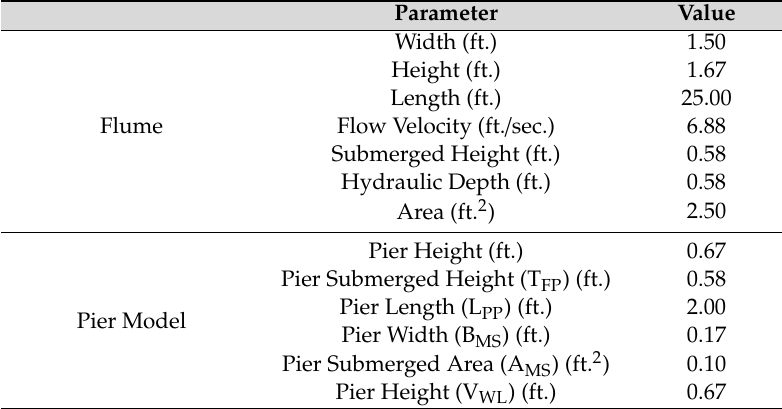
Table 6. Flume and pier model